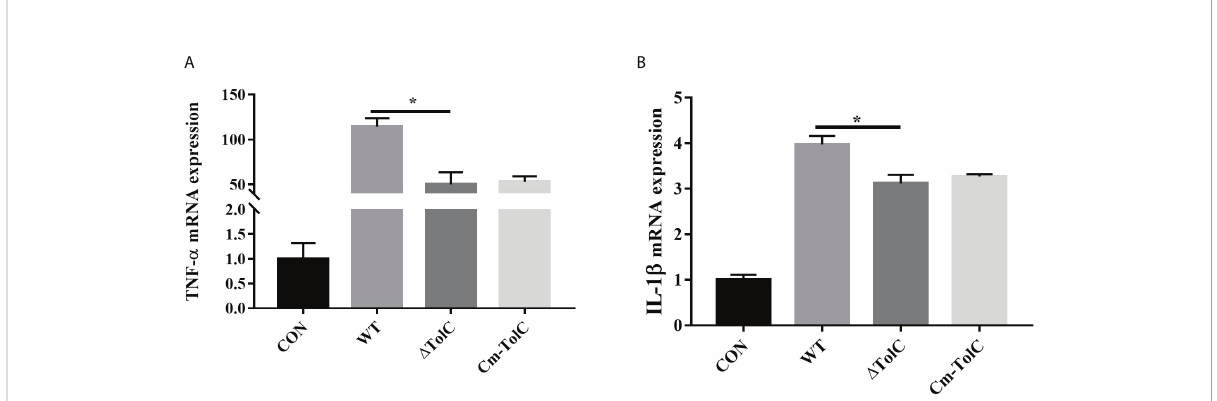
FIGURE 6 Induction of cytokine mRNA expression in PAVECs by stimulation with the WT, D TolC, and Cm-TolC strains. (A) mRNA expression of TNF- a . (B) mRNA expression of IL-1 b . Cytokine mRNA levels were then determined by qRT-PCR. Statistical analyses were performed using a two unpaired t-test. Statistically signi fi cant difference is indicated as * p ≤ 0.05.